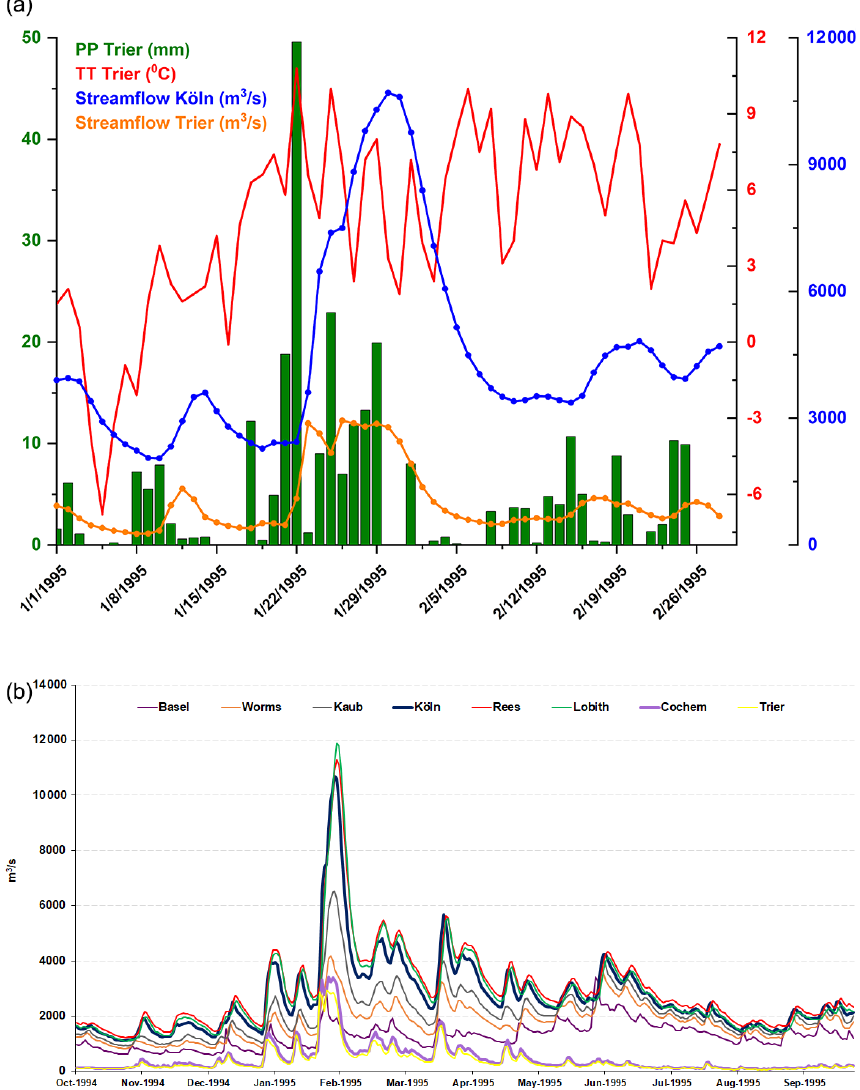
Figure 8. (a) Daily precipitation (green bars) at the Trier meteorological station, daily mean temperature (red line), daily streamflow at the Köln gauging station (blue line) and daily streamflow at the Trier gauging station (orange line) for the period 1 January–28 February 1995. (b) Daily streamflow at different gauging stations along the Rhine (Basel, Worms, Kaub, Köln, Rees and Lobith) and Moselle rivers (Trier and Cochem) for the period 1 October 1994–30 September